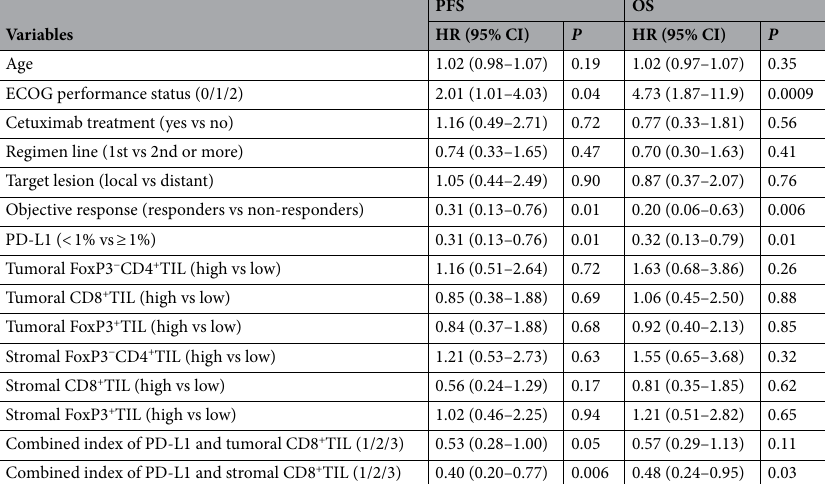
Table 3. Univariate analysis of patients’ PFS and